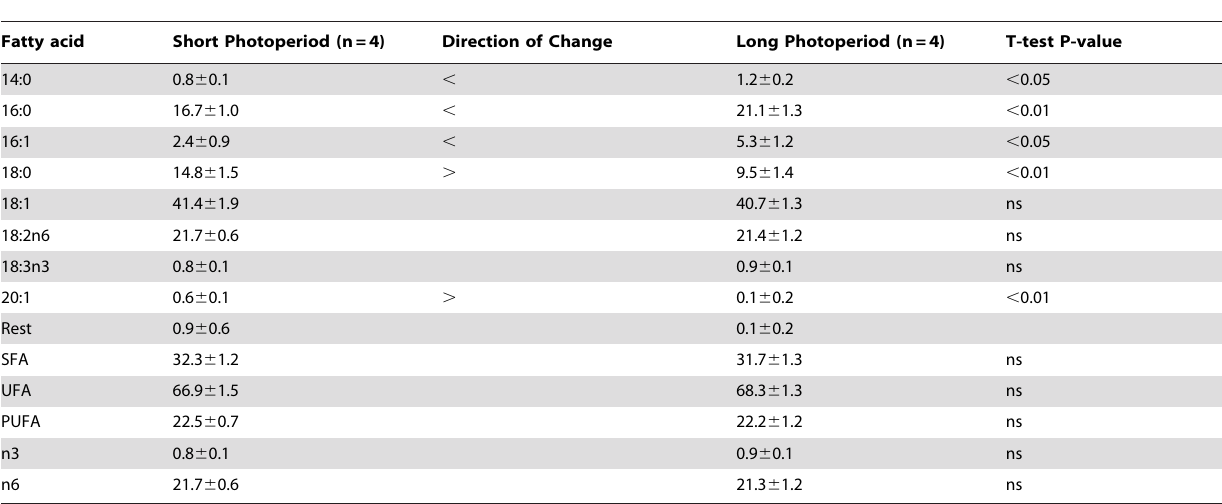
Table 3. Percent fatty acid composition ( . 0.1%) of brown adipose tissue (BAT).